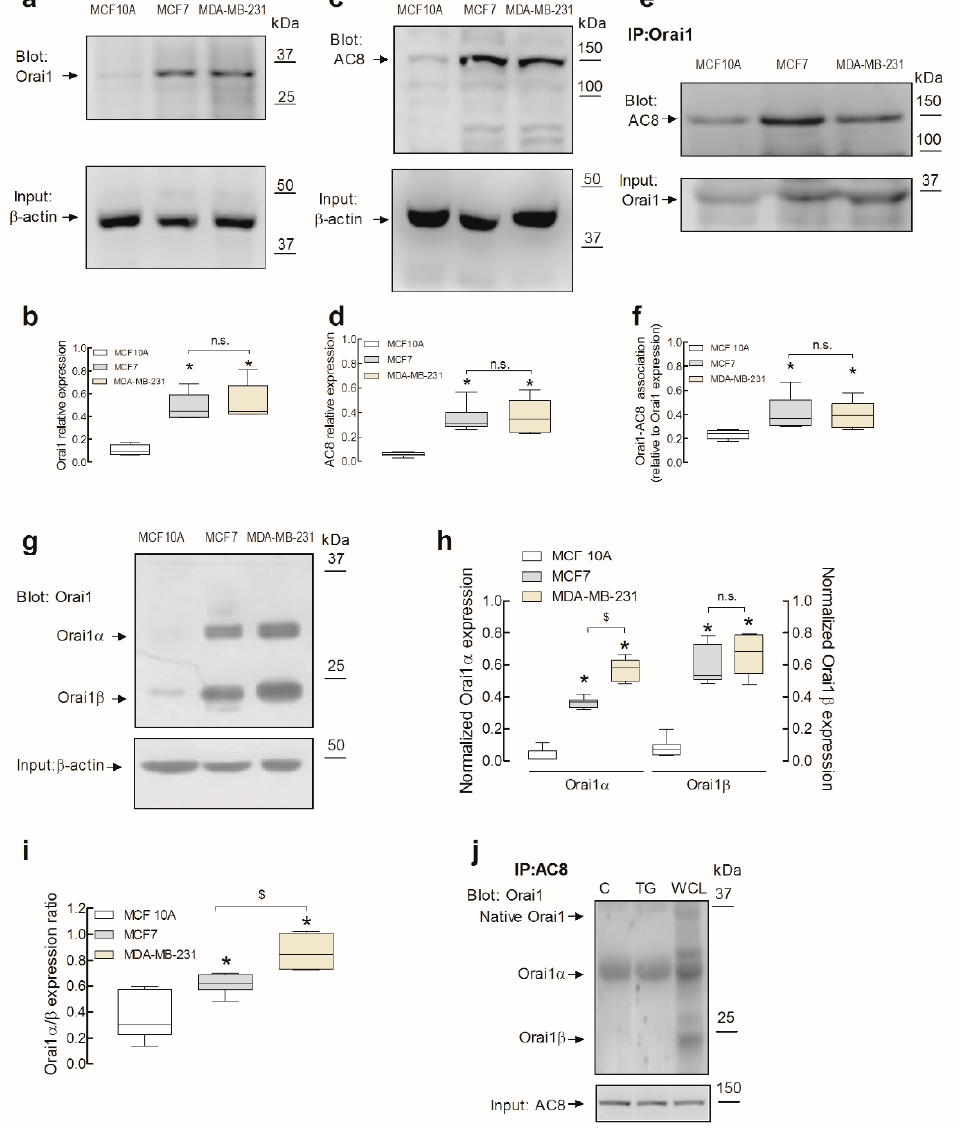
Figure 1. Expression and interaction of Orai1 variants with Ca 2+ calmodulin-activated adenylyl cyclase type 8 (AC8) in non-tumoral and breast cancer cell lines. ( a – d ) Non-tumoral breast epithelial MCF10A and breast cancer MCF7 and MDA-MB-231 cells were lysed and subjected to Western blotting with anti-Orai1 ( a ) or anti-AC8 ( c ) antibody, followed by reprobing with anti- β -actin antibody for protein loading control ( b and d ). The box-and-whisker plots (or box plots) represent Orai1 ( b ) or AC8 ( d ) expression normalized to the β -actin content. Molecular masses indicated on the